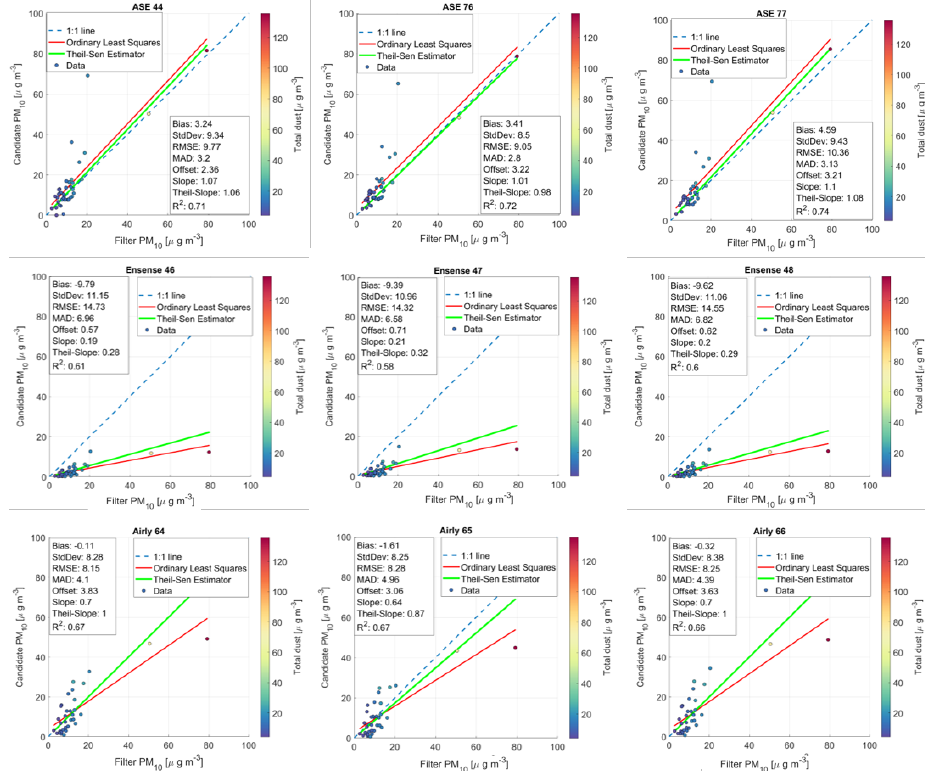
Figure 9. Sensor-to-KFG intercomparison of the factory-calibrated PM 10 signal of the 9 sensors systems against the KFG during the co-location period. Axes labels are shown here in units of µg m − 3 . The dashed blue line represents the 1:1 reference line. The red line shows a linear regression fit to the data (with the corresponding regression statistics and R 2 value provided in the top left corner), whereas the green line indicates Theil–Sen